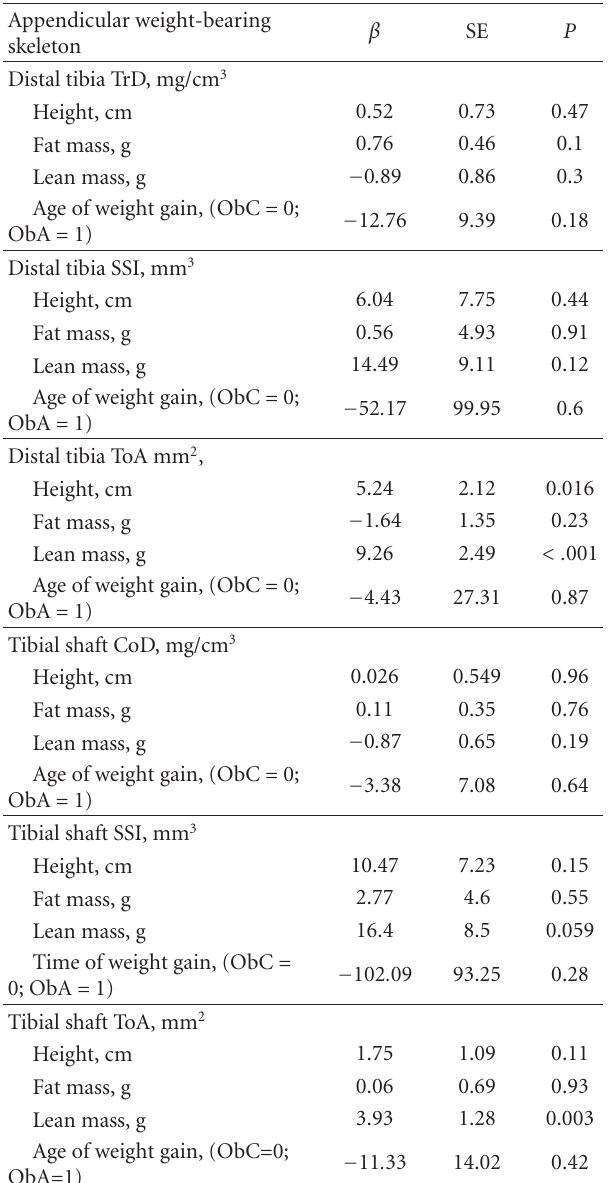
Table 5: Multiple linear regressions showing the simultaneous e ff ects of height, lean, and fat mass and age of weight gain on bone traits in the appendicular weight-bearing